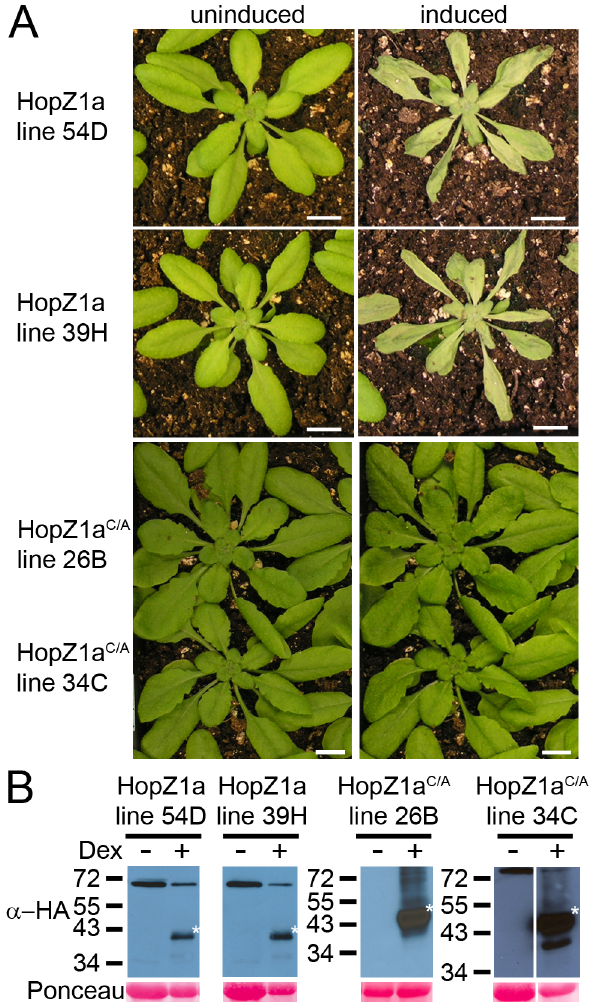
Fig. 1. Transgenically expressed HopZ1a induces a whole plant HR that depends on the catalytic cysteine. (A) Phenotype of transgenic HopZ1a and HopZ1a C/A plants (two independent transgenic lines shown for each genotype) 24 hours after transgene induction by spraying with 30 m M dexamethasone. The same individual for one line is shown before and after dexamethasone treatment. (B) Immunoblot analysis of HopZ1a and HopZ1a C/A proteins expressed in Arabidopsis Col-0 transgenic lines after treatment with 30 m M dexamethasone or water. The Ponceau Red stained blot serves as the loading control. The expected size 42.1 kDa, and the expected band is marked with an